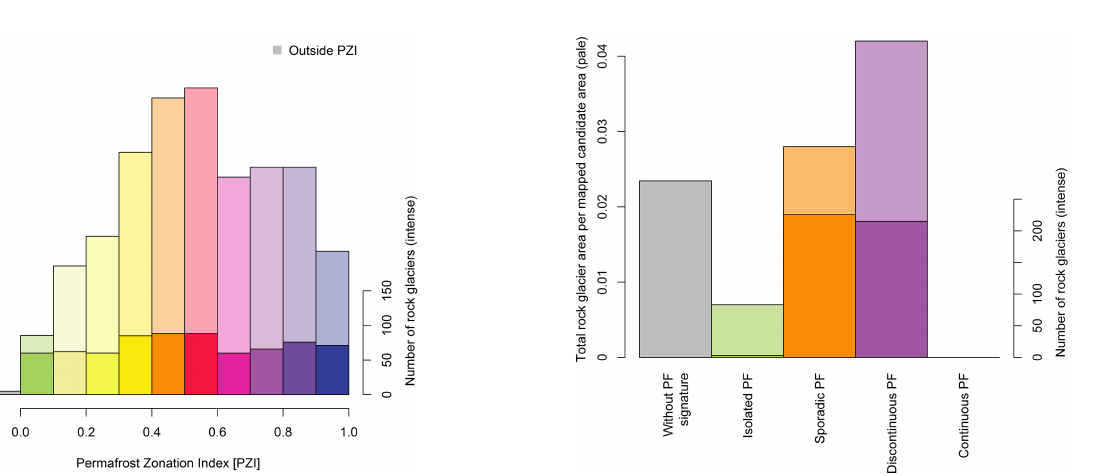
Figure 7. Comparison of all mapped rock glaciers with the Circum- Arctic Map of Permafrost (IPA map). Note that the category “continuous permafrost” does not occur in the investigation area. “Mapped candidate area” refers to areas in which rock glaciers can be expected to occur and to be observed; for each pixel, this is determined based on (a) topography (standard deviation of SRTM90 > 85m in each sample), (b) sufficient image quality in Google Earth, and (c) the absence of glacier cover. Intensive col- ors indicate the number of rock glaciers and pale colors represent the density of rock glaciers within a certain